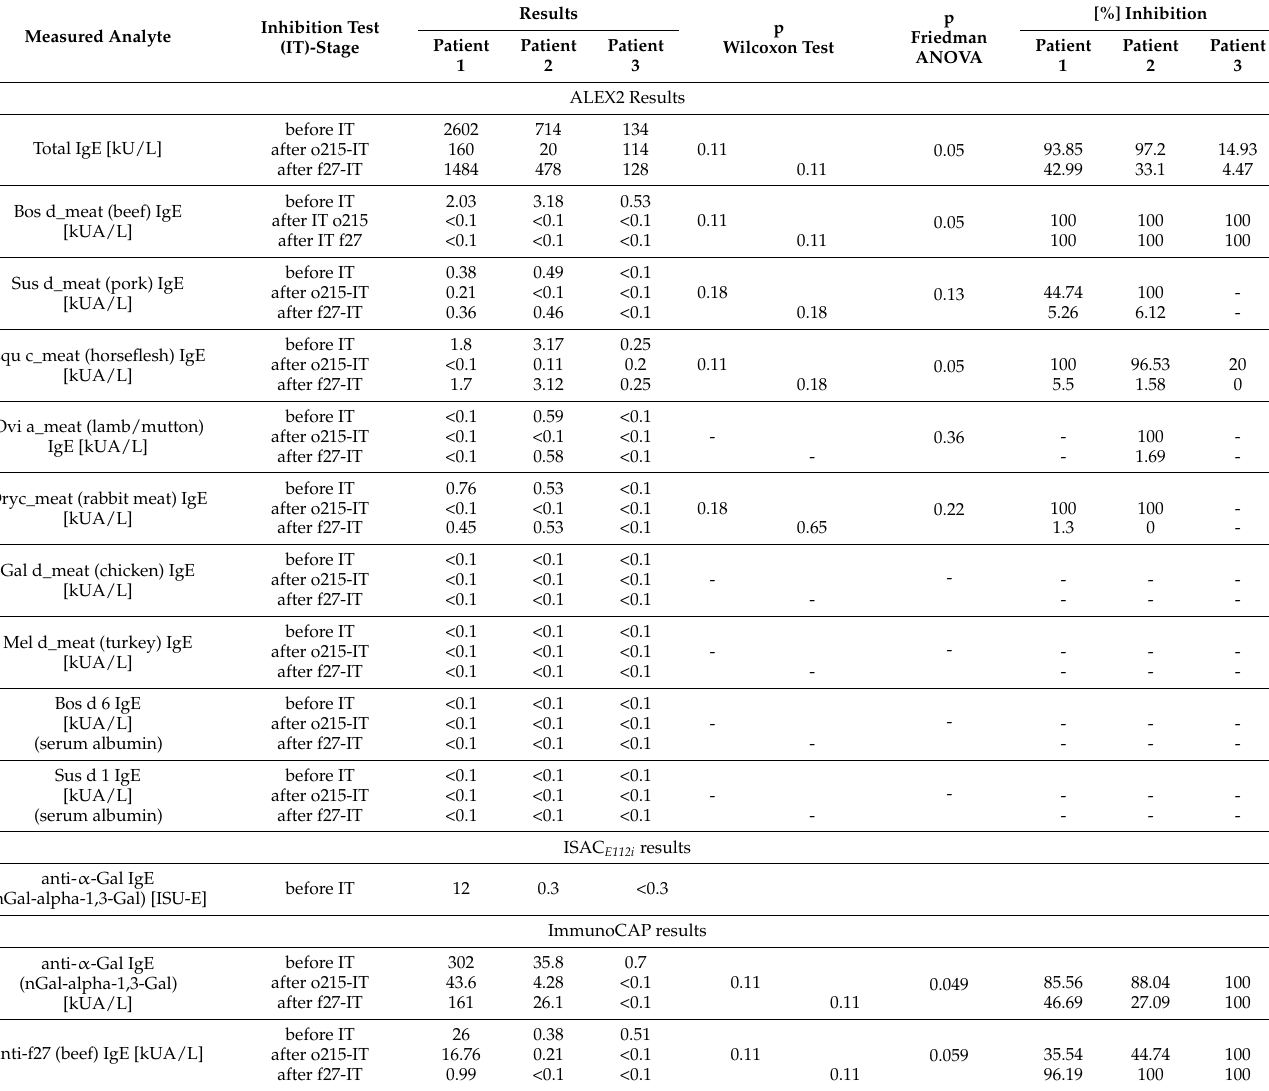
Table 1. Laboratory test results of the patients (case-by-case), before and after inhibition